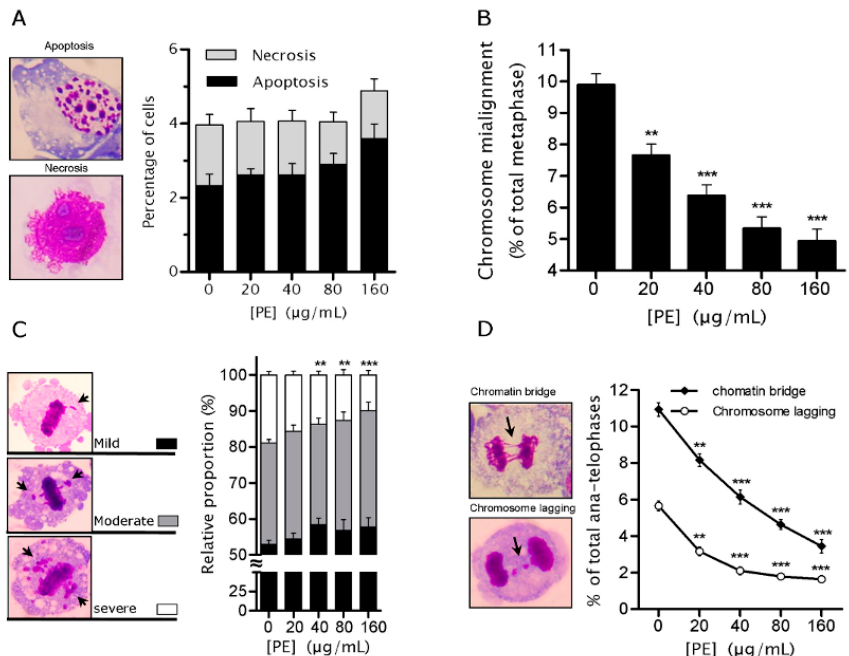
Figure 3. P. emblica (PE) treatment prevented mitotic aberrations in NCM460 cells. NCM460 cells were treated with PE (20–160 µg/mL) for 72 h, and then cells were fixed and stained to quantify assessment of cell death and mitotic aberrations. ( A ) Representative images show apoptosis and necrosis ( left panel ; 100 × oil objective, Giemsa staining) and their incidences in indicated PE doses were quantified ( right panel ); ( B ) Quantification of chromosome misalignment in NCM460 cells from indicated PE doses. A minimum of 200 metaphases was scored for each dose in each of at least three independent experiments; ( C ) For analysis, chromosome misalignment was assessed with mild (one misaligned chromosome), moderate (2–5) and severe (>5) (identified by arrows in left panel; 100 × oil objective, Giemsa staining), and their incidences in indicated PE doses were quantified ( right panel ); ( D ) Representative images show the chromatin bridge, chromosome lagging during ana-telophase (denoted by arrows in the left panel; 100 × oil objective, Giemsa staining) and their incidences in indicated PE doses were quantified ( right panel ). A minimum of 50 metaphases was scored for each dose in each of 14 independent experiments. Giemsa-stained DNA is in red, and the cytoplasm is in blue. Data are expressed as mean values ± SEM. ** p < 0.01, *** p < 0.001 vs. untreated control.